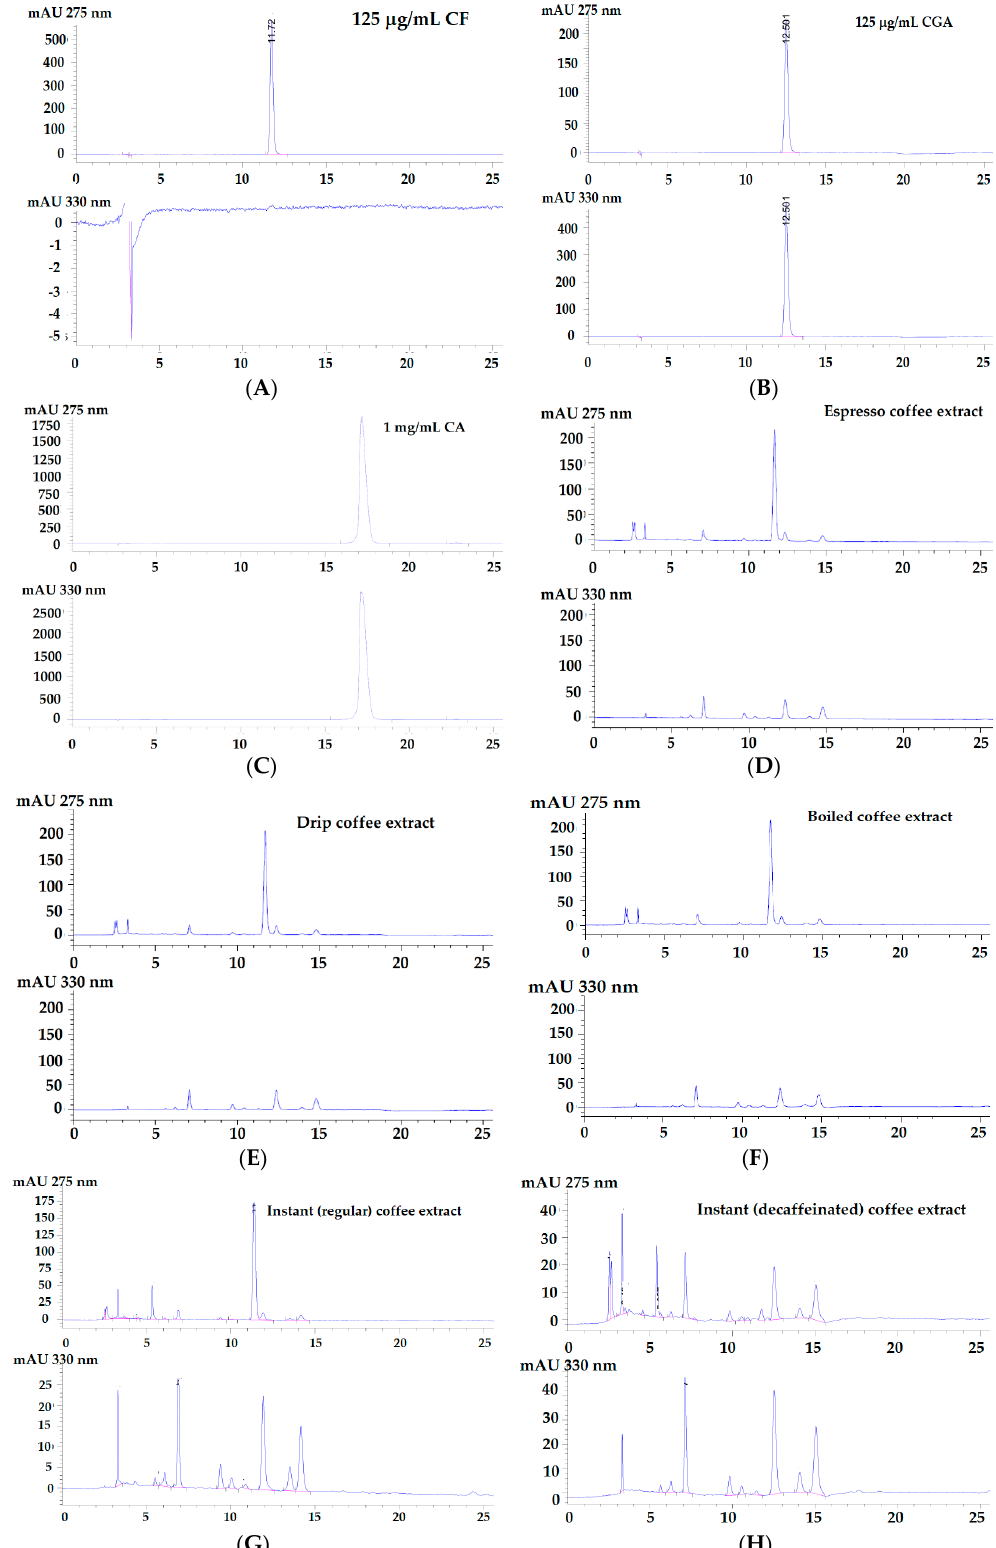
Figure 2. HPLC/DAD profiles of authentic standards including caffeic acid (CA), caffeine (CF), and chlorogenic acid (CGA); espresso, drip, boiled and instant coffee extracts ( A – H ).